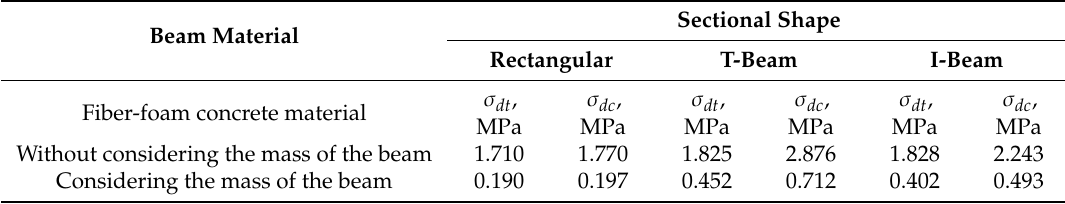
Table2. Maximumdynamicstressesarisinginbeamsofrectangular, T-andI-shape, withoutbimodularity. E t = 5000 MPa; E c = 5000